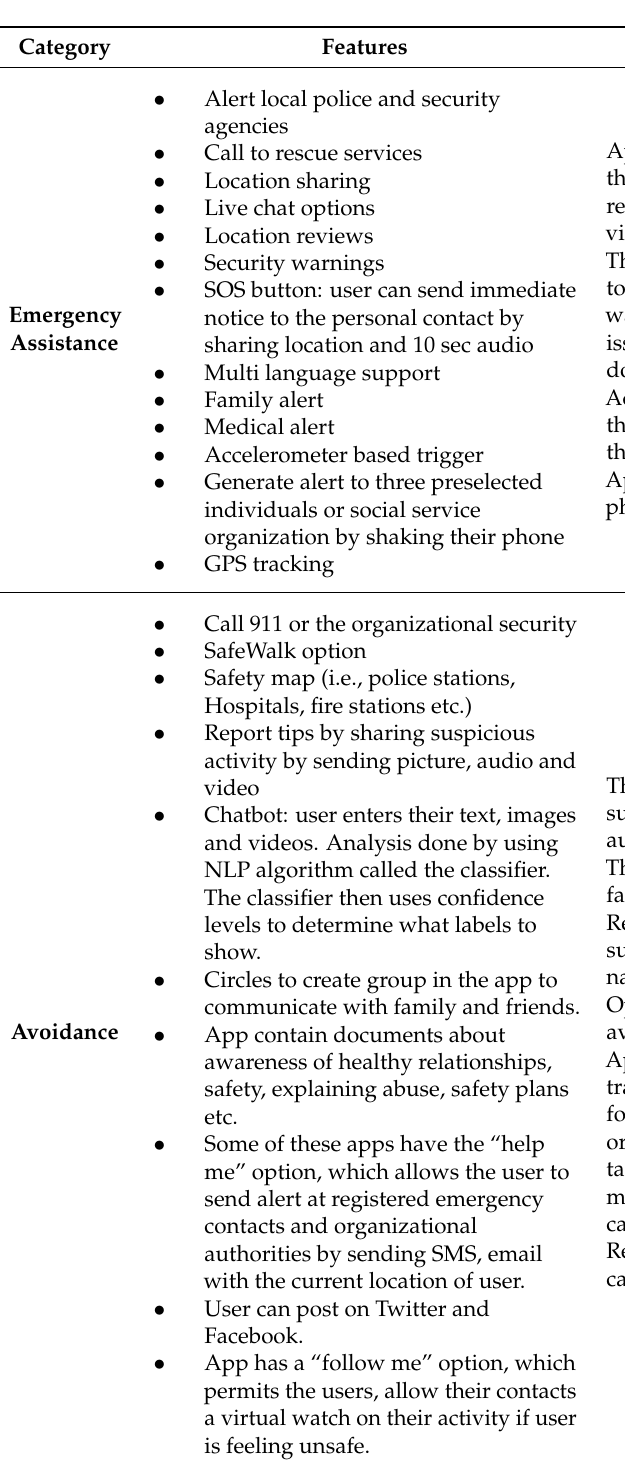
Table 1. Detailed features of domestic violence